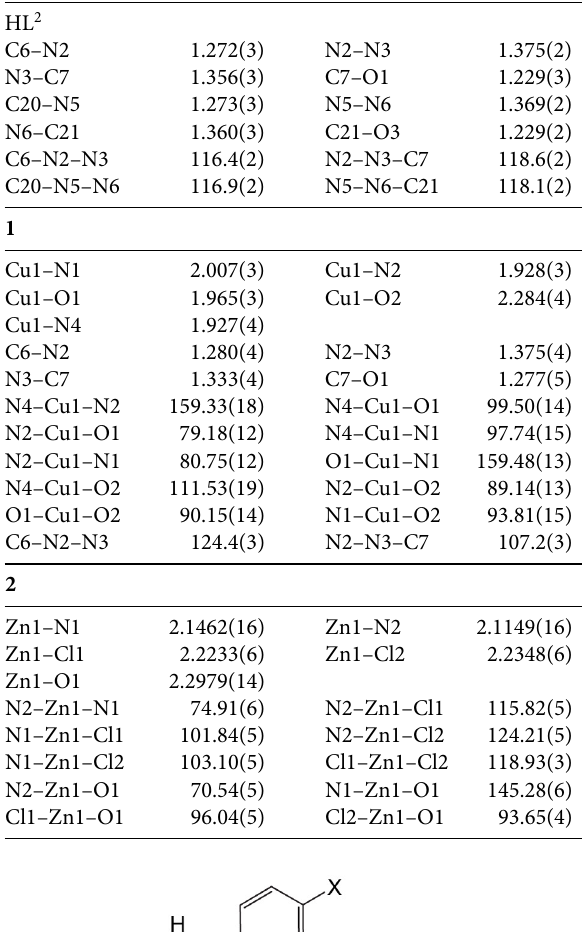
Table 2. Selected bond lengths/Å and angles/° for the